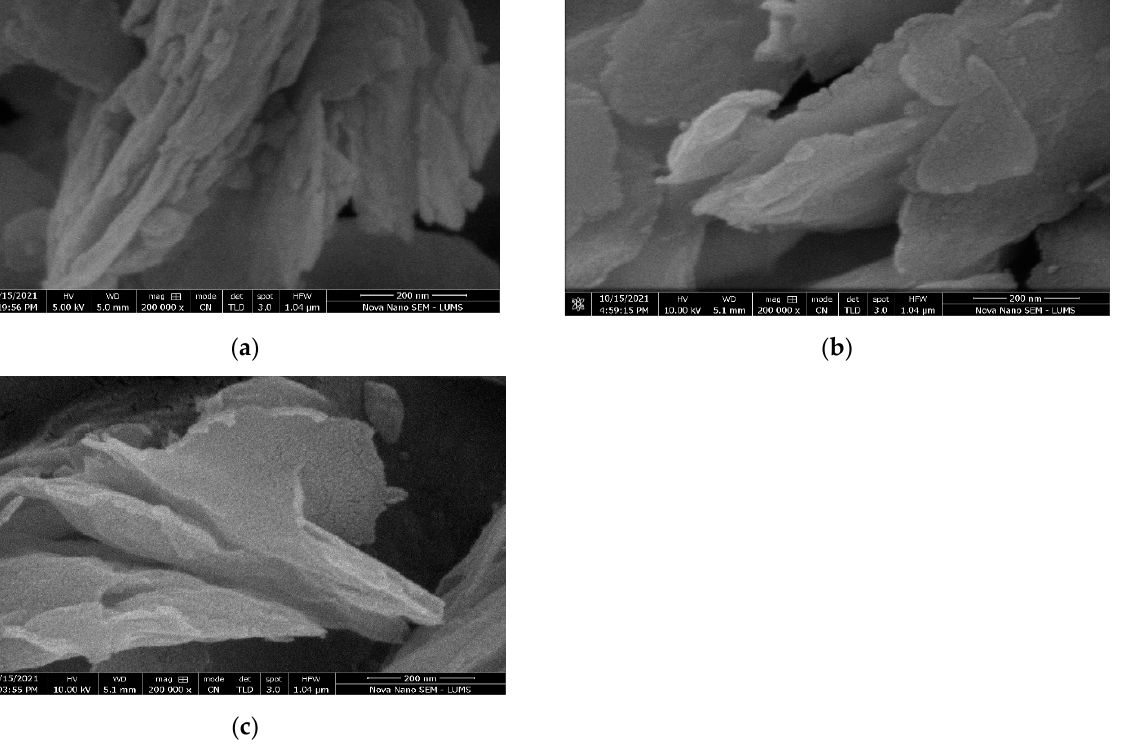
Figure 7. SEM images at 200 nm ( a ) pure bentonite ( b ) bentonite treated with sodium metasilicate ( c ) bentonite treated with sodium metasilicate and potassium ferricyanide.